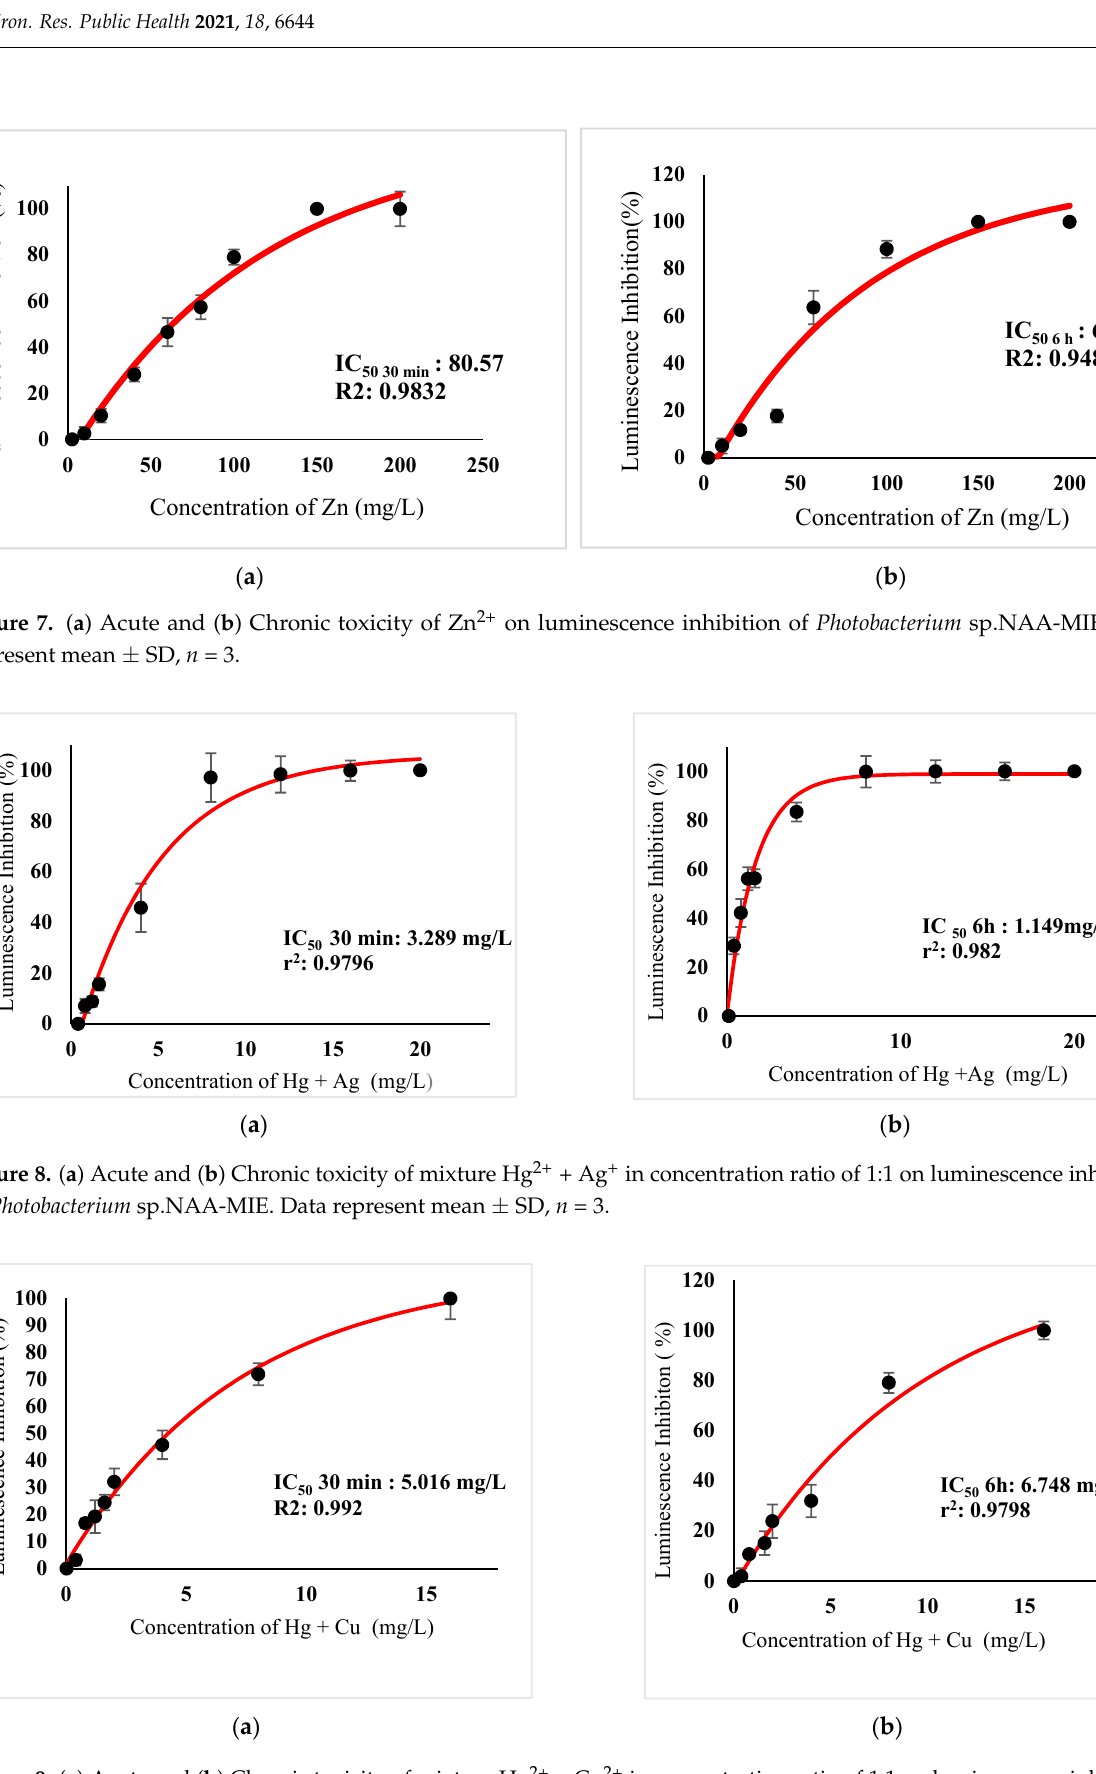
( b ) Figure 10. ( a ) Acute and ( b ) Chronic toxicity of mixture Ag + + Cu 2+ in the concentration ratio of 1:1 on luminescence inhi- bition of Photobacterium sp.NAA-MIE. Data represent mean ± SD, n = 3. ( a ) ( b ) Figure 11. ( a ) Acute and ( b ) Chronic toxicity of mixture Hg 2+ + Ag + + Cu 2+ in the concentration ratio of 1:1:1 on luminescence inhibition of Photobacterium sp.NAA-MIE. Data represent mean ± SD, n = 3.